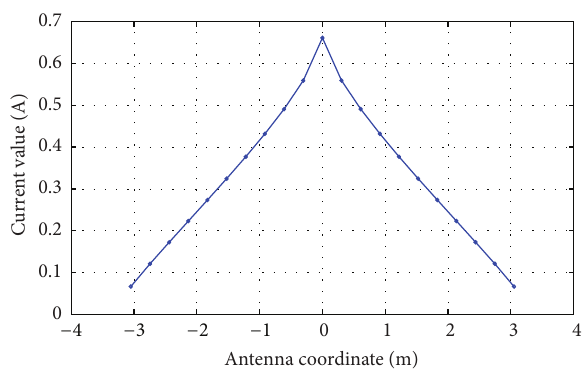
Figure 2: Current distribution on the wire antenna